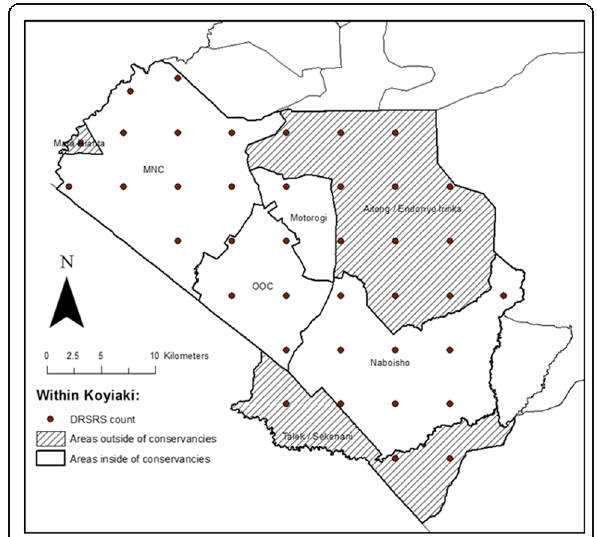
Figure 2 DRSRS 5 × 5 km 2 sampling units inside and outside conservancies in Koyiaki Group Ranch